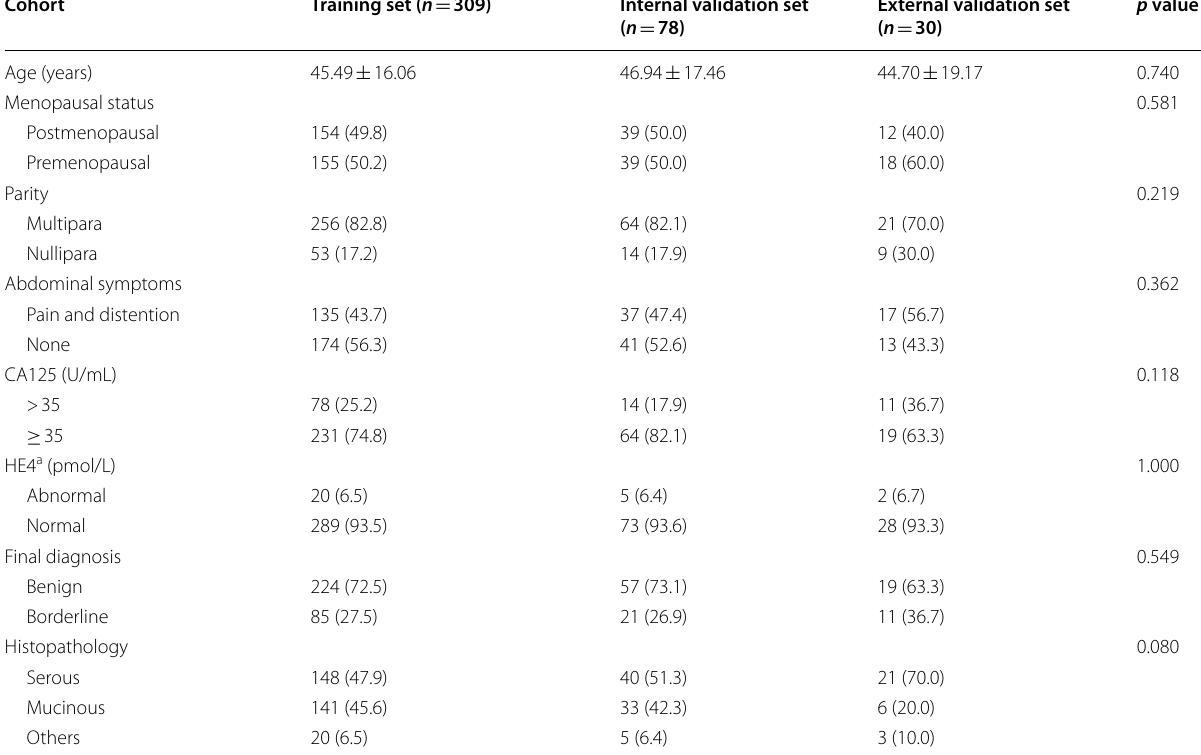
Table 1 Clinical characteristics of training and validation